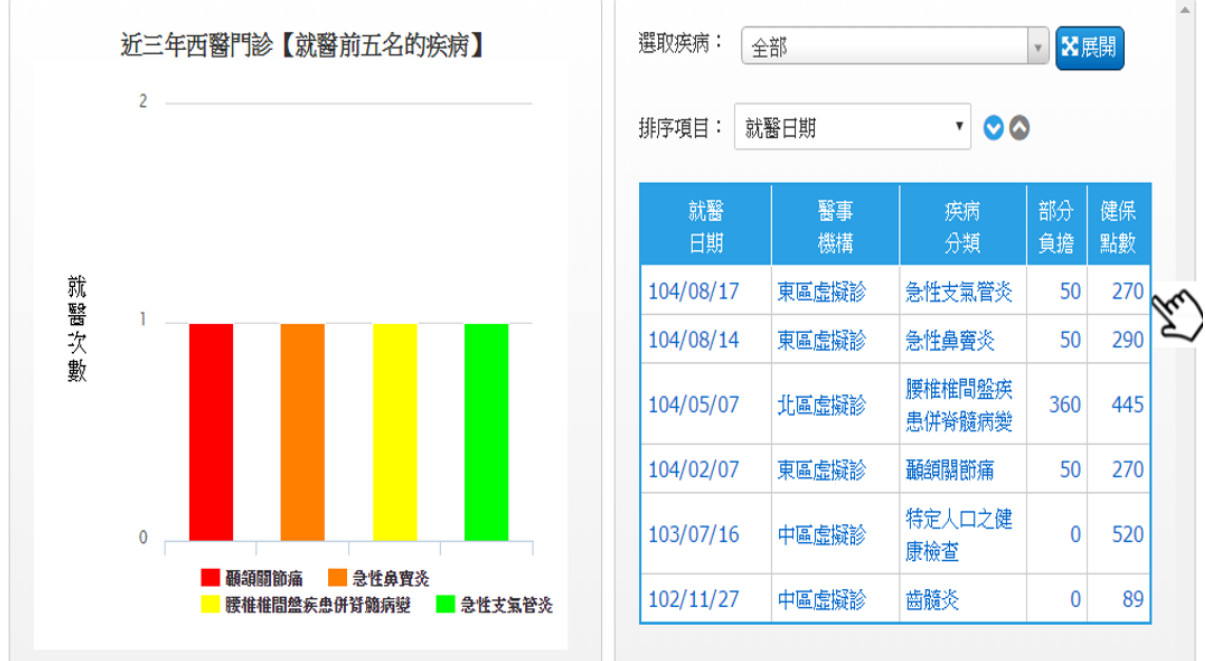
Figure 1. Medical data visualization (screenshot from My Health Bank): People can query information about outpatients (emergency department and hospital) and medical diagnoses over the past 3 years. Statistical results are presented